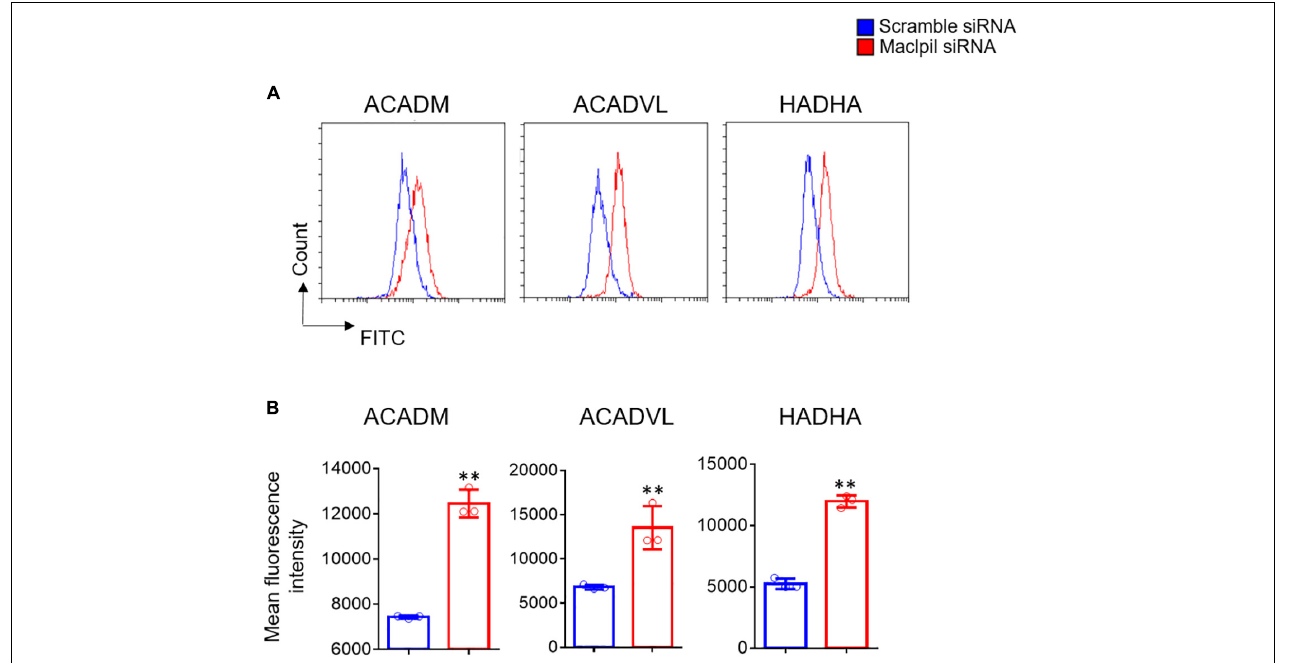
FIGURE 7 | siRNA silencing Maclpil increases the expression of key fatty acid oxidation enzymes in macrophages undergoing oxygen glucose deprivation treatment. Following oxygen glucose deprivation treatment, marrow-derived macrophages (BMDCs) were stained with unlabeled primary antibodies against ACADM, ACADVL, and HADHA followed by incubation with fluorochrome-conjugated secondary antibodies and analyzed on a flow cytometer. (A) Representative flow cytometric overlay histograms showing the staining for ACADM, ACADVL, and HADHA in Maclpil and scramble siRNA-treated BMDCs after oxygen glucose deprivation. (B) Quantification of the expression levels (mean fluorescence intensity, mean and SD, n = 3) of ACADM, ACADVL, and HADHA in differentially treated BMDCs. Student’s t -test, ∗∗ p < 0.01 compared to scramble siRNA